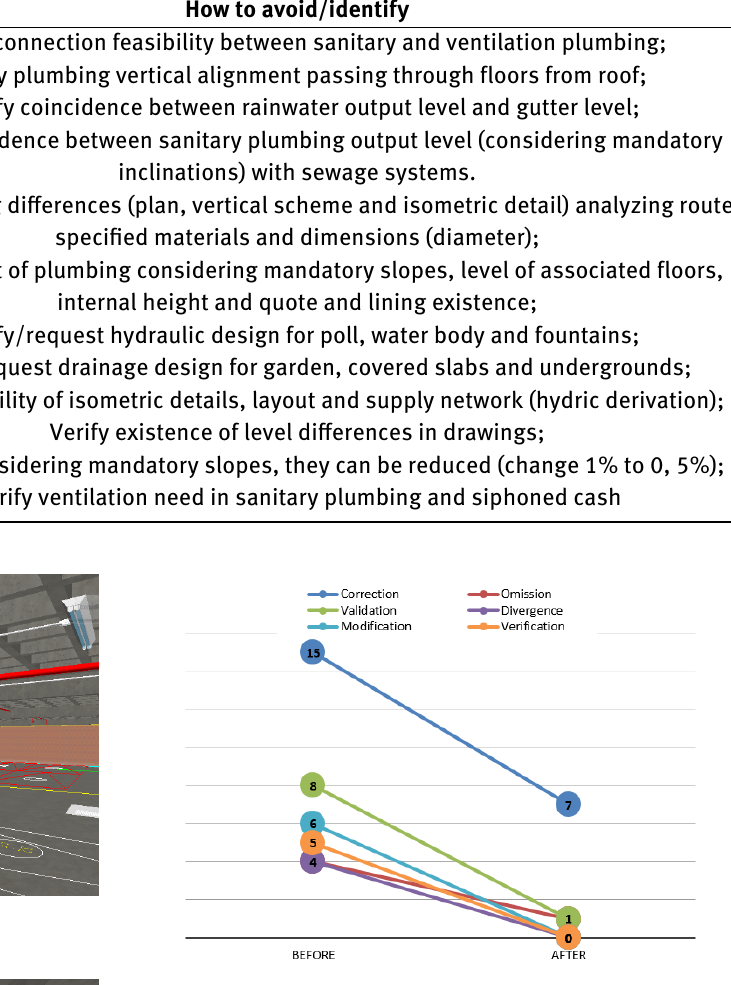
Figure 7: RFI classified reduction in each